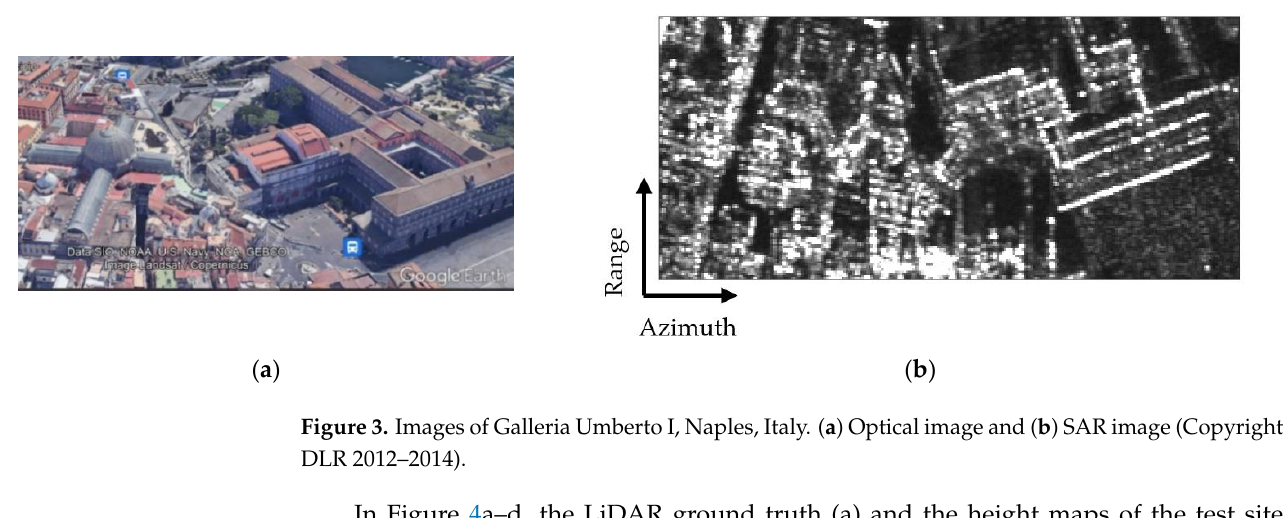
Figure 4. Galleria Umberto I test site: ( a ) LiDAR height map; ( b ) Single-look GLRT height map; ( c ) MGLRT height map obtained using a 3 × 3 patch; ( d ) MGLRT height map obtained using a 5 × 5 patch.